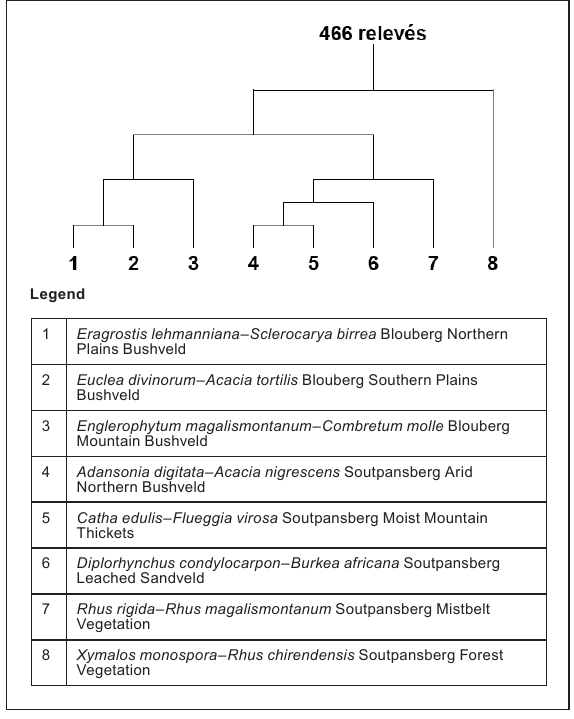
Figure 3 A dendrogram showing the hierarchical divisions created by the TWINSPAN (Two Way INdicator SPecies ANalysis) computer software package (Hill